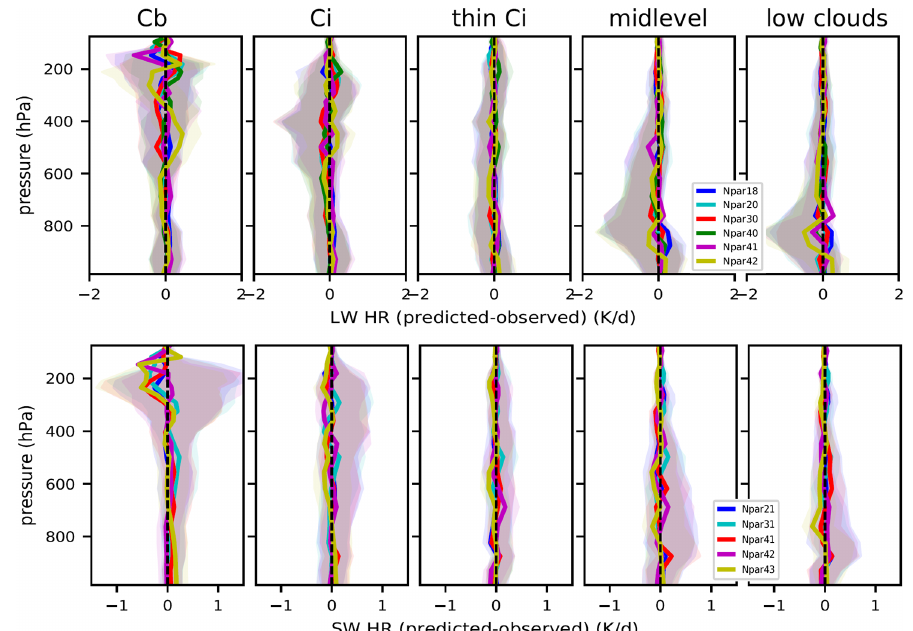
Figure 2. Sensitivity results concerning surface, atmospheric and cloud input parameters for the prediction of cloud LW radiative heating rates (above) and SW radiative heating rates (below): difference between predicted and observed vertical profiles of the validation dataset, separately for Cb, cirrus, thin cirrus and mid- and low-level clouds, as identified by AIRS-CIRS, over tropical ocean. 30% and 70% quantiles of the distributions are also shown. Compared are results of the experiments 1–6 (above) and 2–6 (below), using the input parameters listed in Table 1.